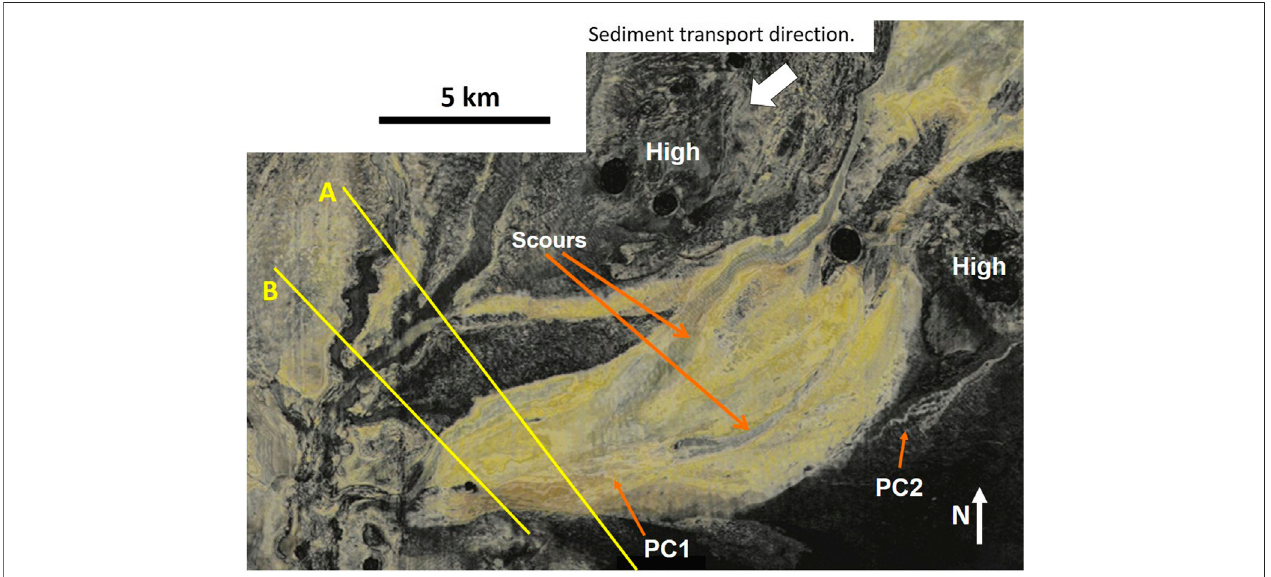
FIGURE 6 | A Root Mean Squared (RMS) amplitude extraction from a 3D re fl ection seismic volume on the middle slope, off shore Nigeria. See Figures 4 , 5 for location. The image, which includes LE2, is calculated from the interval between 50 and 100 ms (approximately 50 m of sediment) below seabed. The sampled interval corresponds tothe interval between blue lines in Figure 7 . High RMS values are displayed aswhiteto yellow colors. Sediment transport isfrom northeast to southwest. Dark, elongate, low sinuosity features with non-parallel sides, interpreted as scours within LE2, are labeled (Scours). Small possible channel forms may be seen locallywithinLE2 (PC1) aswell asoutside ofLE2 (PC2).In fl uential structuralhighs areannotated(High).The locations ofseismic cross sections in Figure 7 areindicated by yellow lines labeled (A) and (B) .